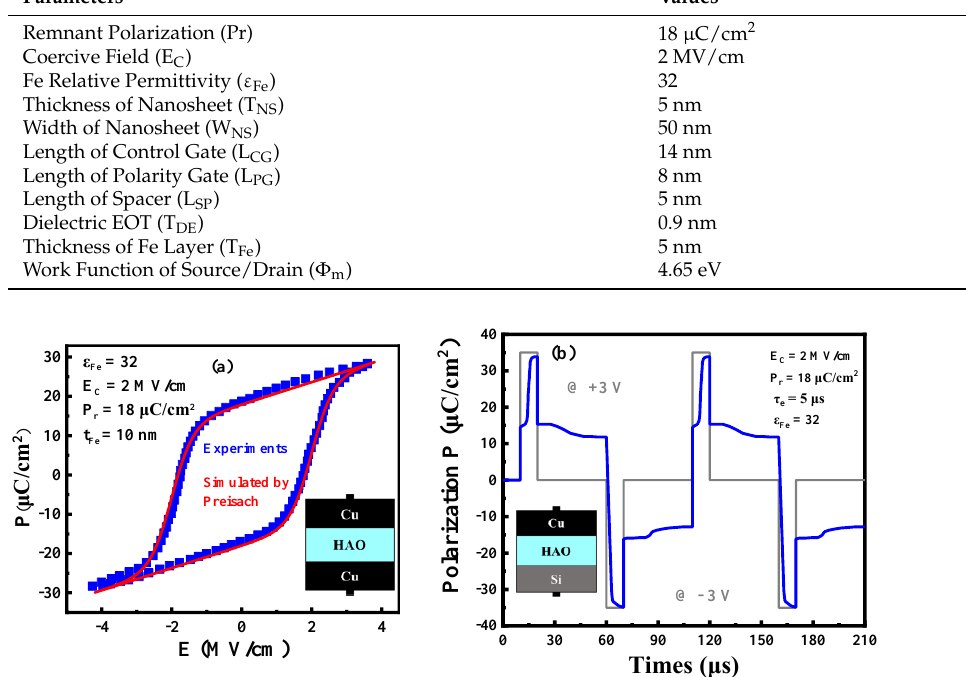
Figure 4. ( a ) Simulated and measured P-E curves, with fitting parameters extracted. ( b ) Simulation of polarity gate’s polarization response to the square waves of ±3 V for 10 µs. of polarity gate’s polarization response to the square waves of ± 3 V for 10 µ